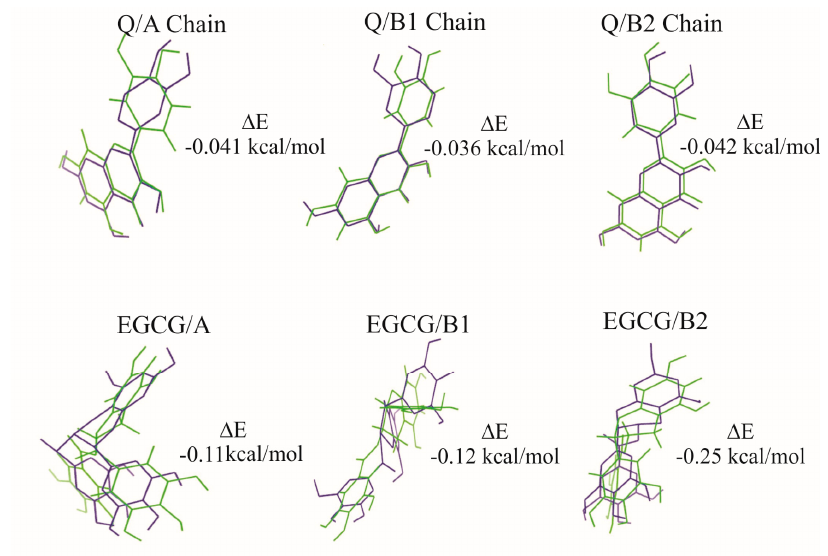
Figure 8. An adjustment and alignment of the ligands Q and EGCG before (green) and after (blue) the interaction with A and B chains of the ricin protein. interaction with A and B chains of the ricin